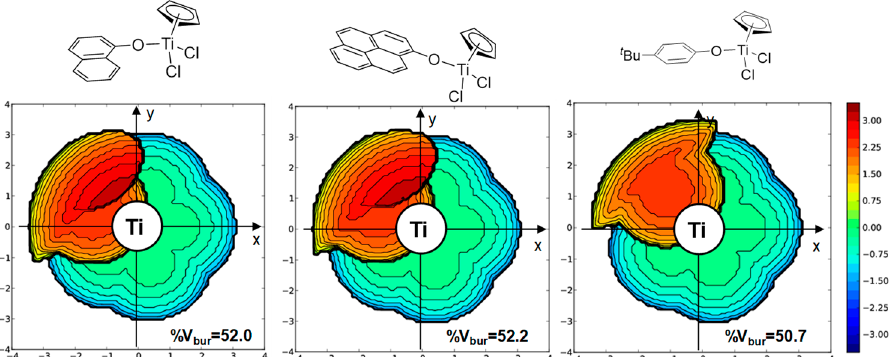
Figure 6. Steric crowding maps from buried volume calculations for unstacked Ti1 ( left ) and Ti3 ( middle ) CpTiCl 2 (O(4- t BuPh) ( right ).